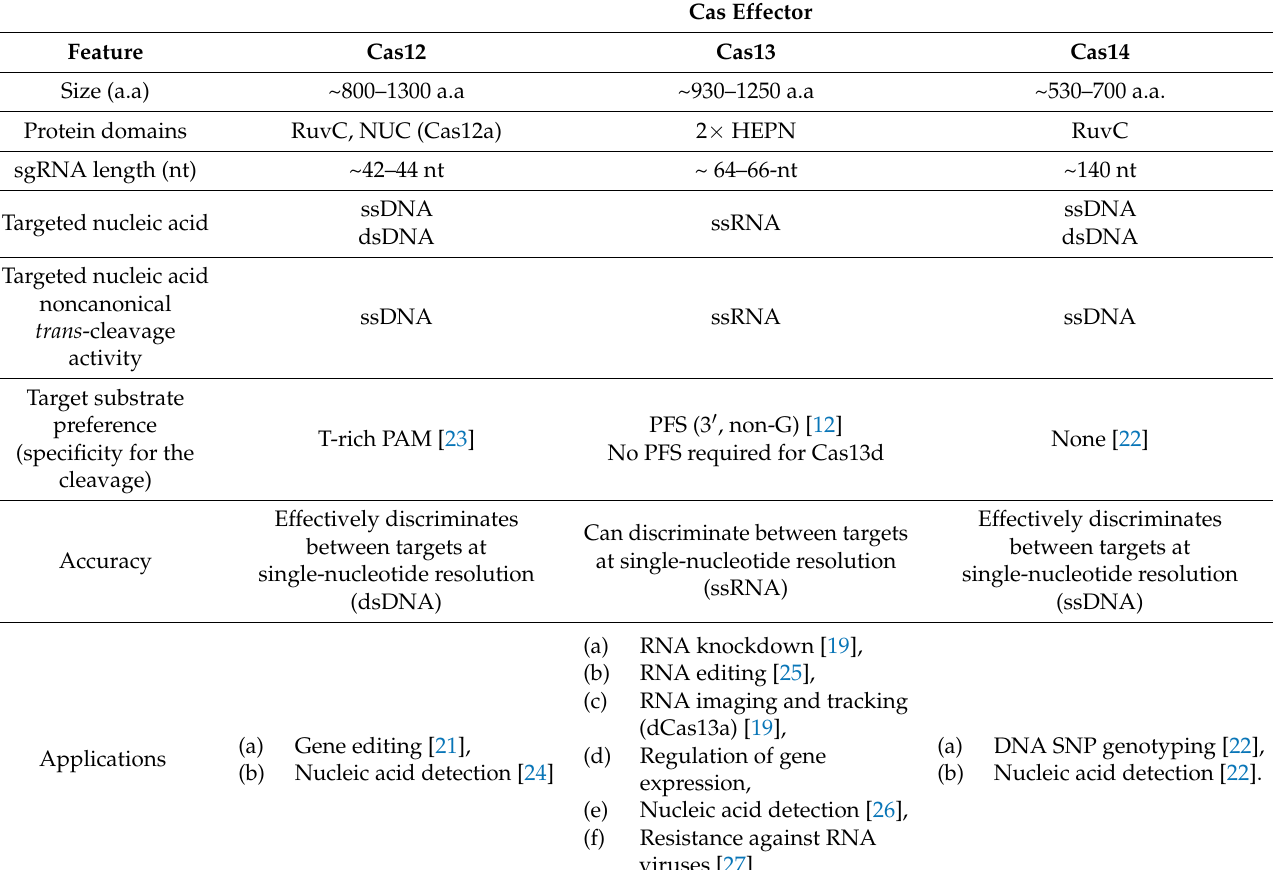
Table 1. Comparison of the main features of Cas12, Cas13, and Cas13 protein